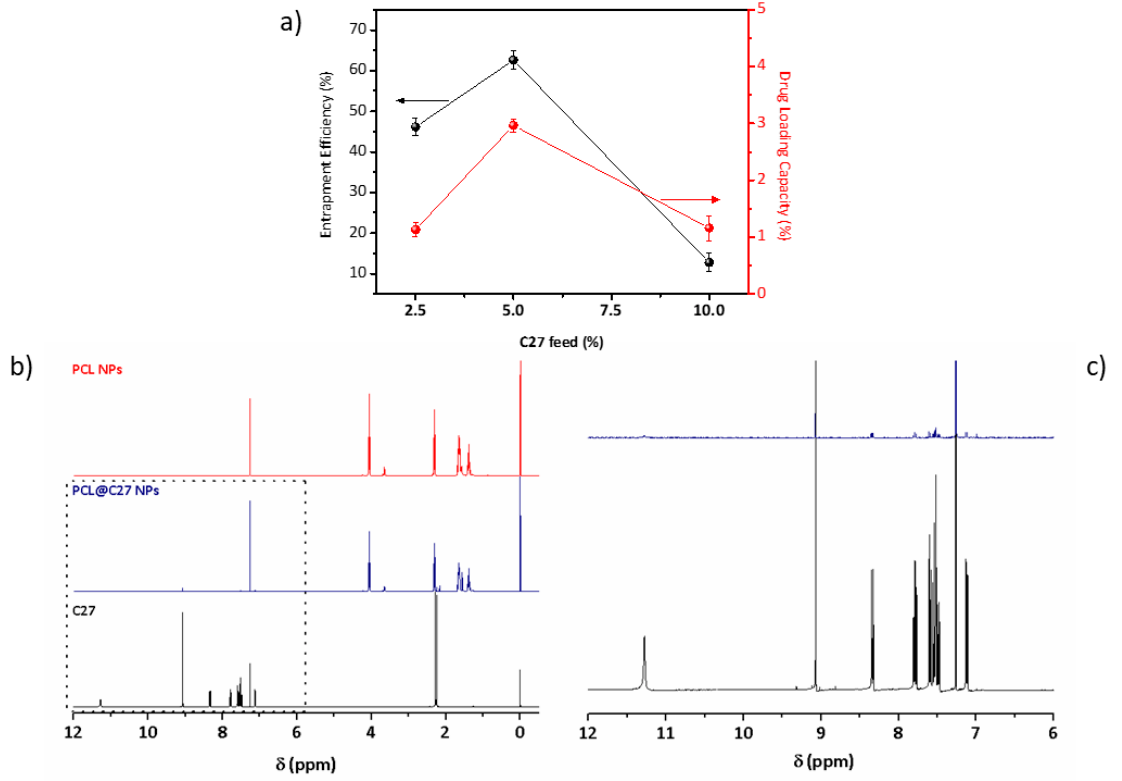
Figure 2. Physicochemical characterization of PCL@C27 nanoformulation by ( a ) determination of the encapsulation efficiency (EE%) and drug loading capacity (DLC%) of NPs fed with different amounts of chromone C27 (2.5, 5, and 10%). ( b ) Structural characterization of C27, PCL NPs, and PCL@C27 NPs using 1 H NMR between 0 and 12 ppm, and ( c ) respective magnification between 12 and 6 ppm of C27 1 H NMR spectra. Values of entrapment efficiency (EE%, black) and drug loading capacity (DLC%, red) obtained for PCL@C27 NPs prepared with different amounts of feeding C27. Measurements of C27 quantification were performed in triplicate and results are presented as mean ± SD.